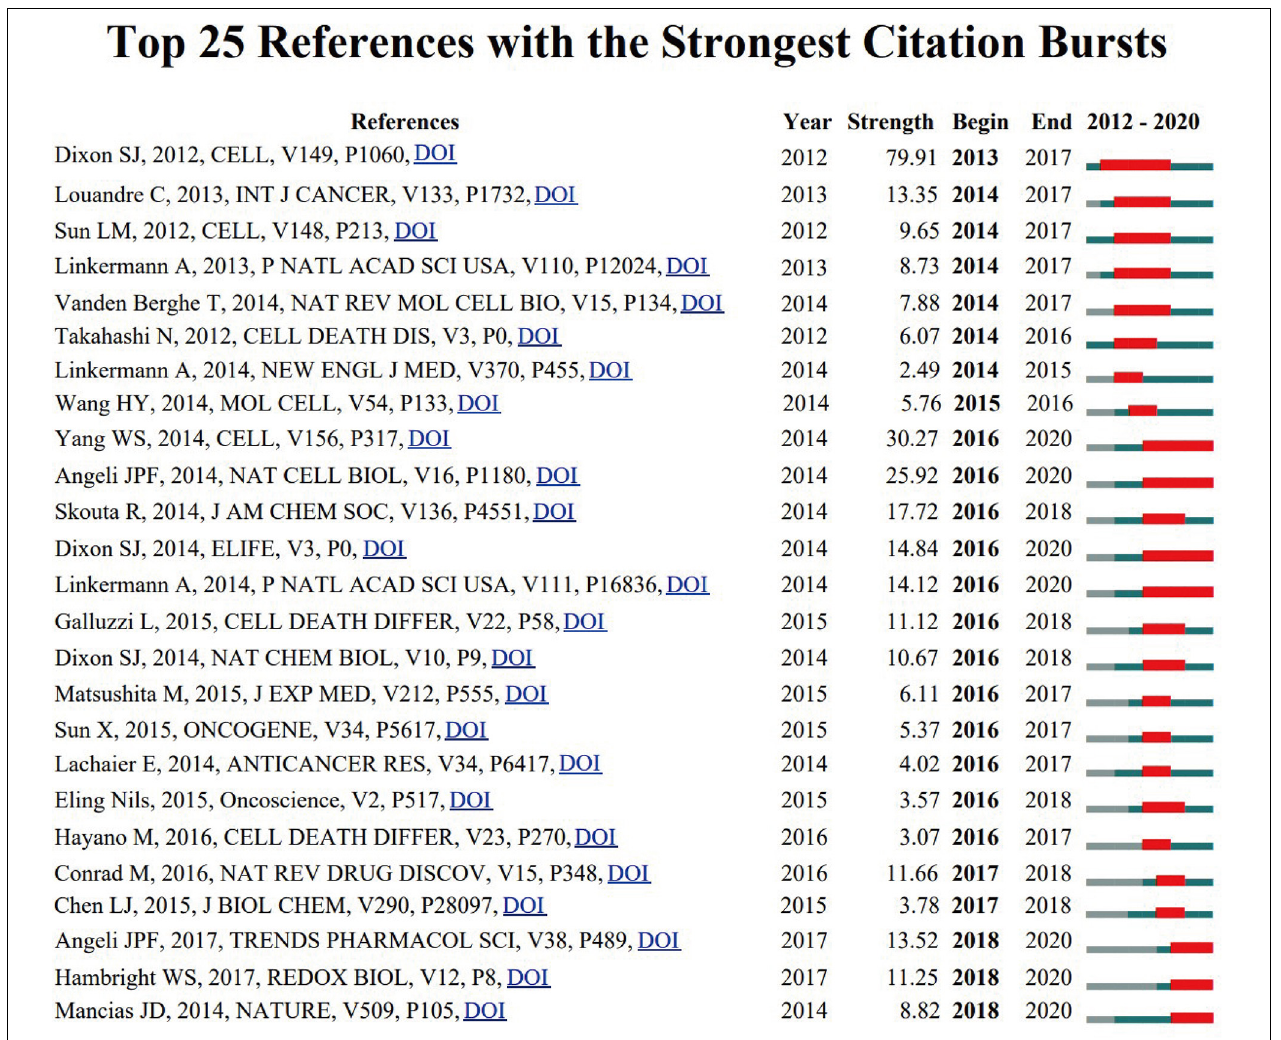
FIGURE 8 | The top 25 references with the strongest citation bursts during 2012 to